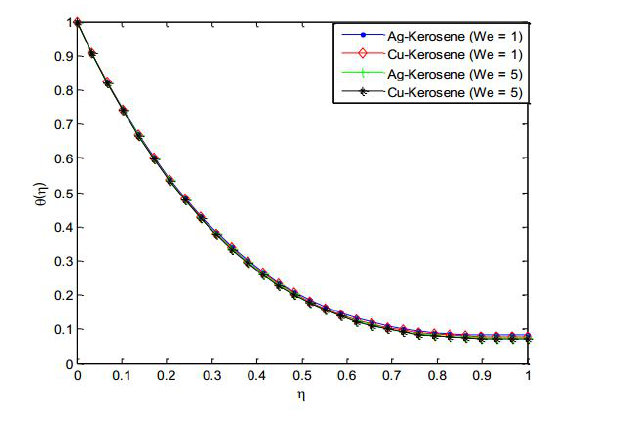
Figure 11. Effect of Weissenberg number on the fluid temperature distribution